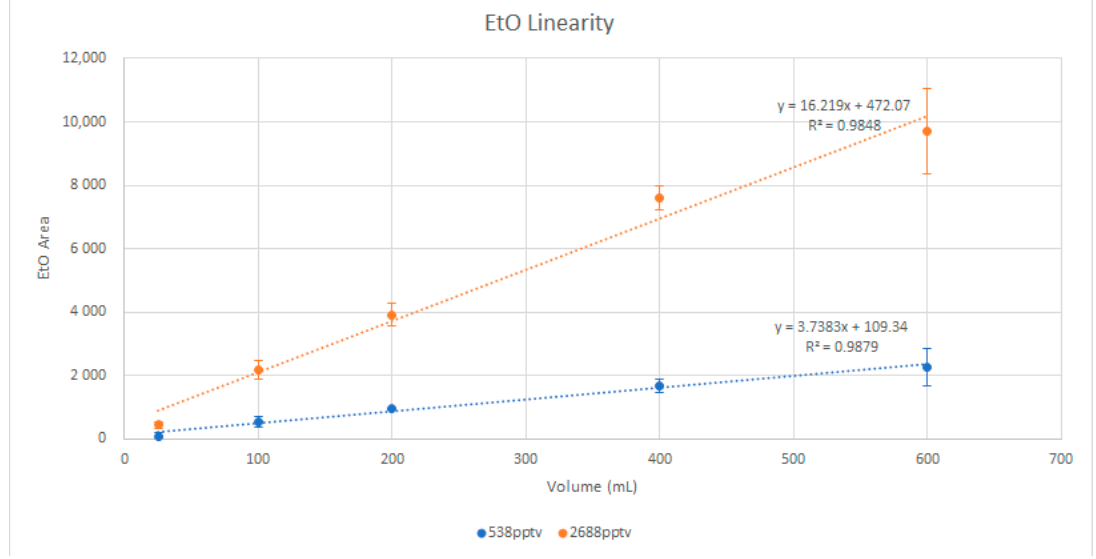
Figure 1. EtO injection